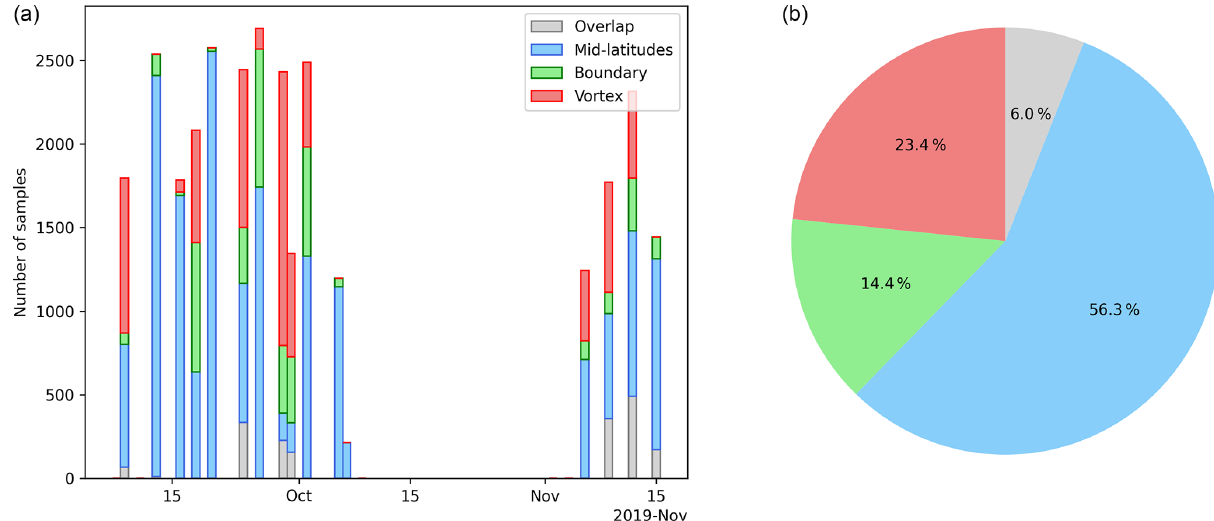
Figure 3. Air sampling statistics of the SouthTRAC campaign. (a) The number of classified measurements. Each column represents a single scientific flight. Stacked bars indicate vortex (red), vortex boundary (green), midlatitudes (blue), and undefined (grey) amounts. (b) Percent- age of each region in the total of all measurements in the scope of the classification (above (cid:49)(cid:50) of 20K).